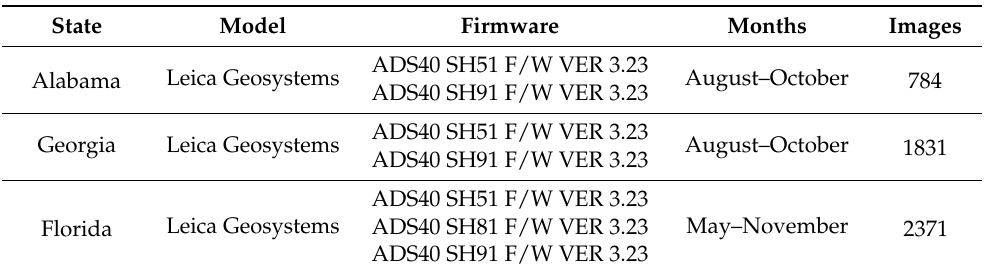
Table 2. Digital cameria model, firmware, and range of acqusition months for National Agricultural Imagery Program (NAIP)